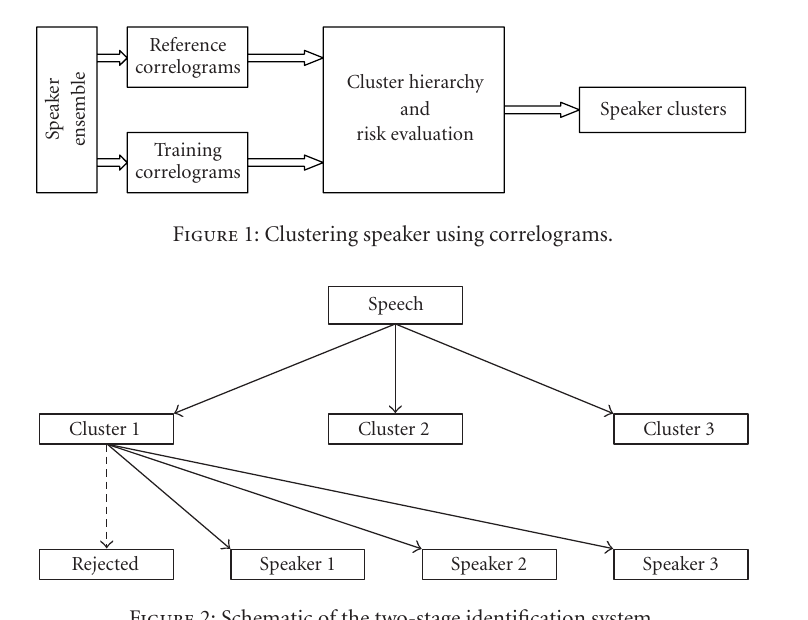
Figure 2: Schematic of the two-stage identification